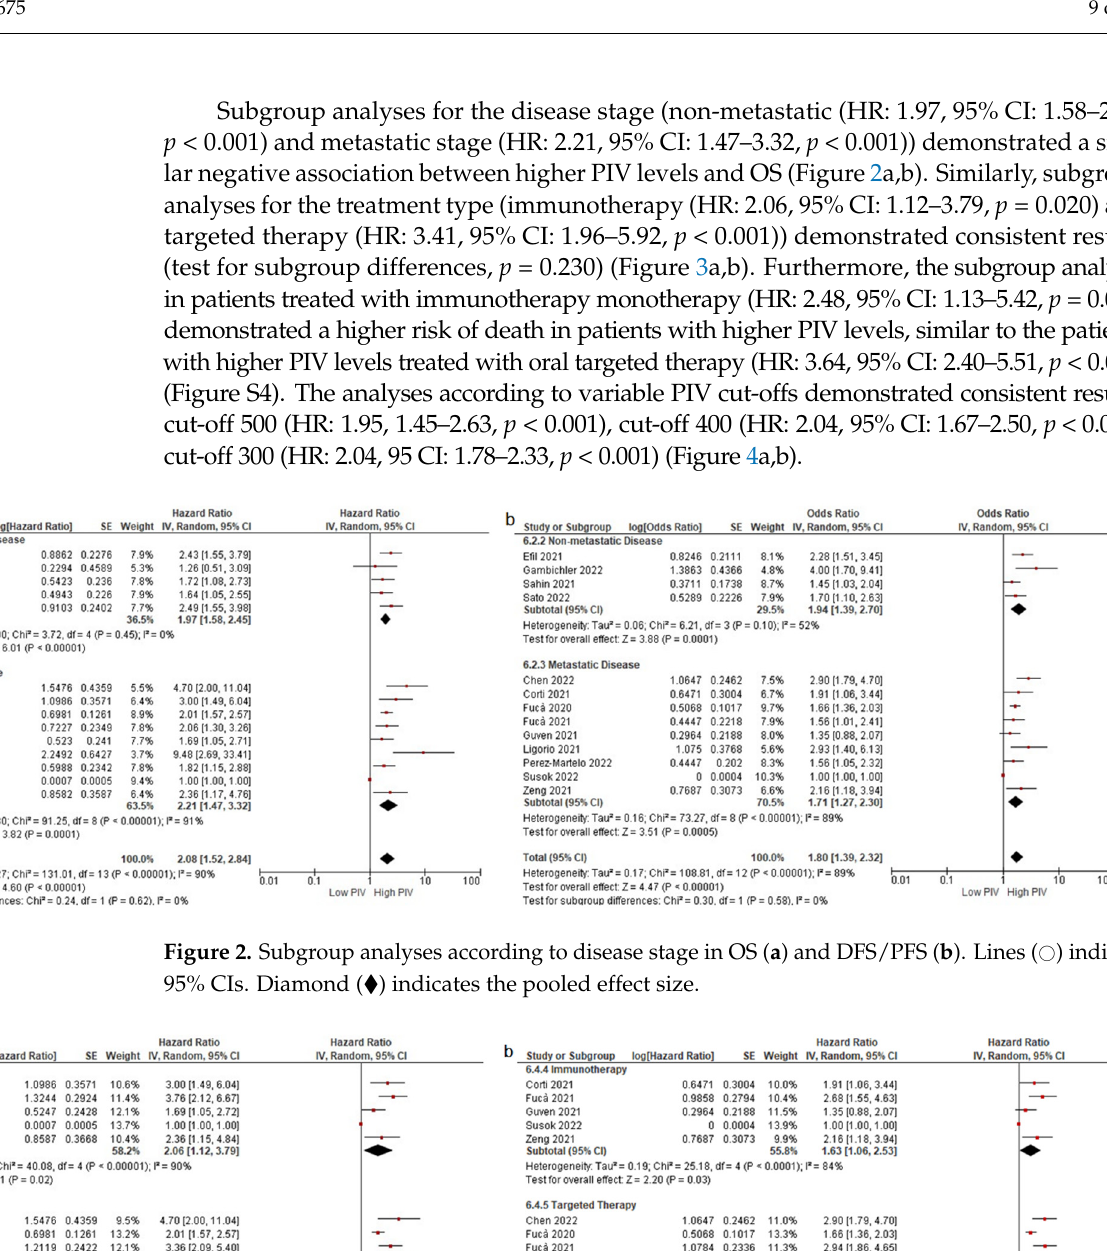
Figure 3. Subgroup analyses according to treatment type in OS ( a ) and DFS/PFS ( b ). Lines ( ○ ) indicate 95% CIs. Diamond ( ♦ ) indicates the pooled effect size.